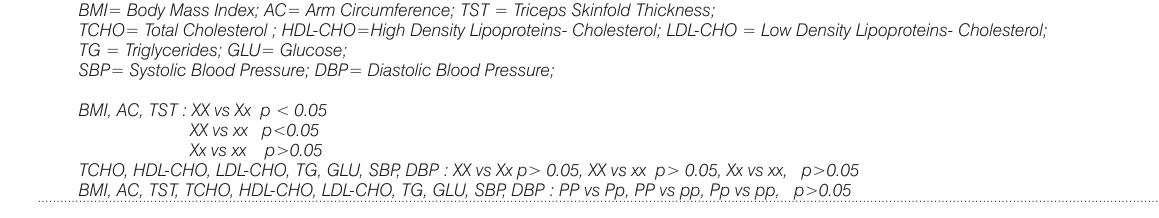
BMI= Body Mass Index; AC= Arm Circumference; TST = Triceps Skinfold Thickness; TCHO= Total Cholesterol ; HDL-CHO=High Density Lipoproteins- Cholesterol; LDL-CHO = Low Density Lipoproteins- Cholesterol; TG = Triglycerides; GLU= Glucose; SBP= Systolic Blood Pressure; DBP= Diastolic Blood Pressure; BMI, AC, TST : XX vs Xx p < 0.05 XX vs xx